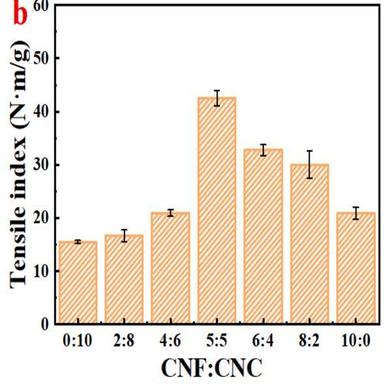
Mechanical properties of nanocomposite films with different ratios of CNF/CNC: (a) Tensile strength and elongation at break, (b) tensile index.